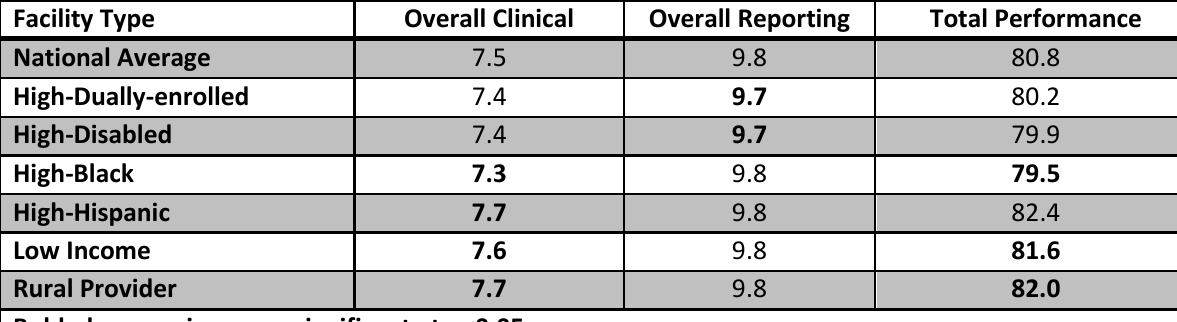
Table 11.6b: Total Scores for PY2015